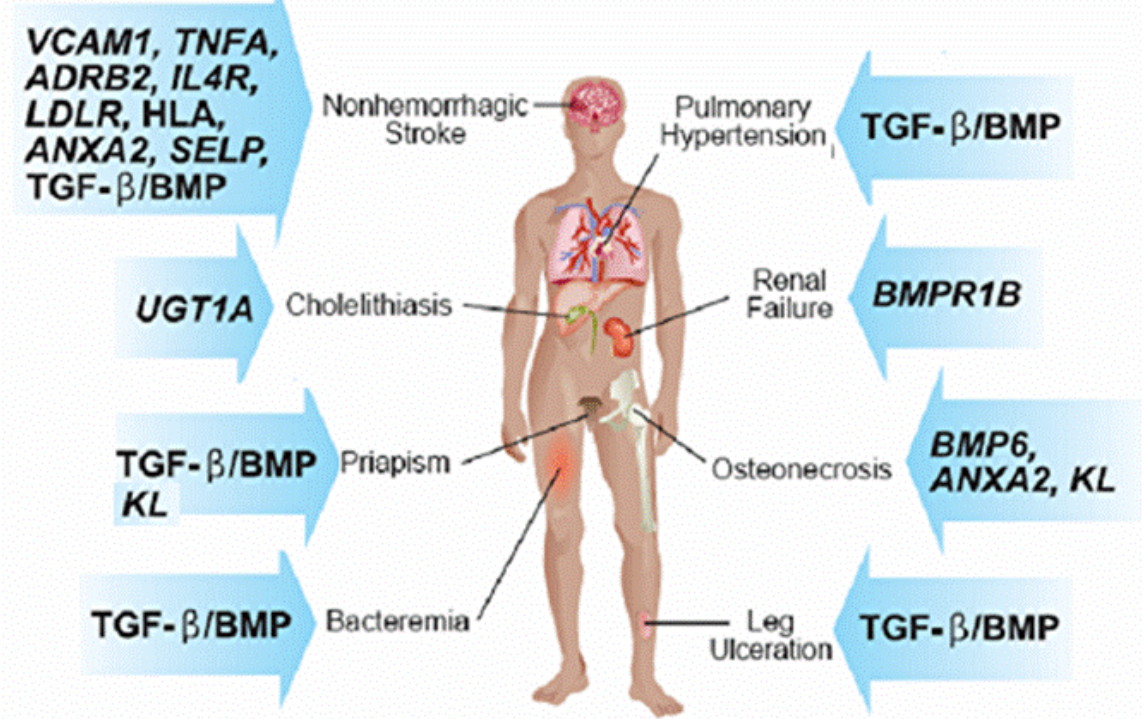
FIGURE 3. Analysis of SNPs in candidate genes suggest associations with subphenotypes of sickle cell anemia. For details of these associations and references, please see the text. (Modified from